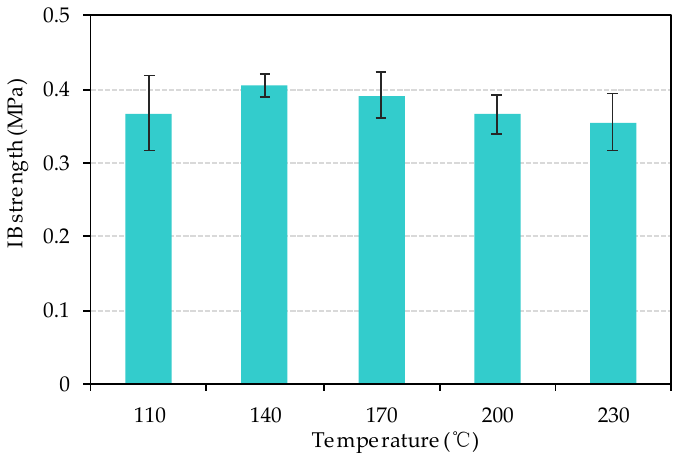
Figure 11. IB strength of bio-board at di ff erent temperature ( p > 0.05).